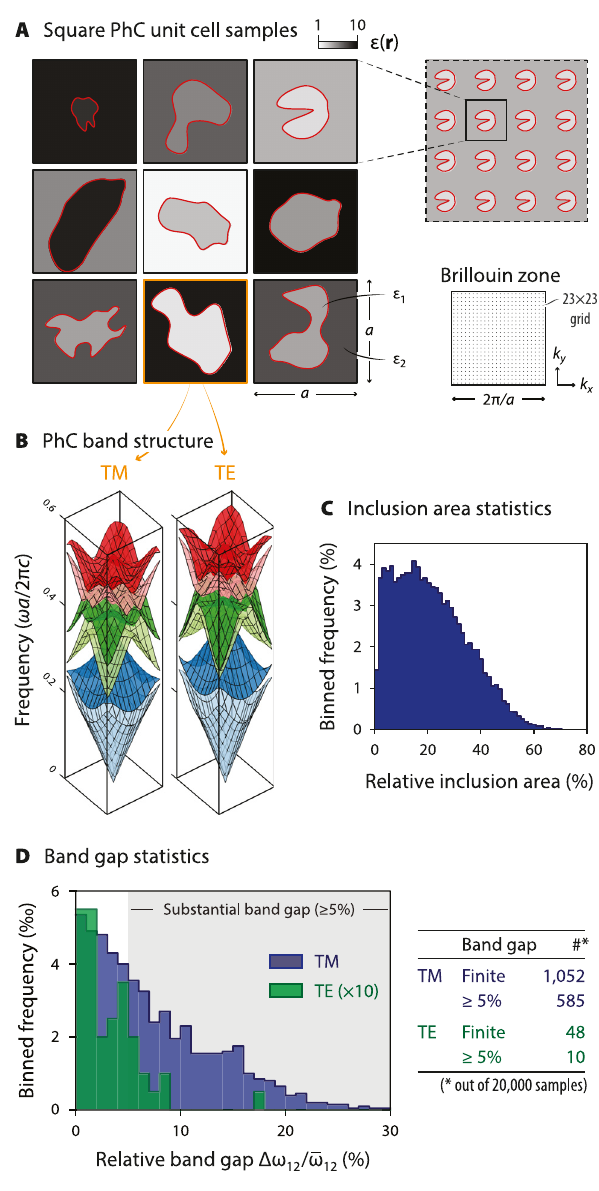
Figure 1: Photonic crystal data set. We generated a data set of 20,000 square 2D PhC unit cells, each consisting of a smooth, centered inclusion of permittivity ε 1 in a background permittivity ε 2 with ε i ∈ [ 1 , 10 ] . (A) Several representative unitcells and theBZ grid- sampling used in the calculation of band structures. (B) The TM and TE band structures of the PhC highlighted in orange in (A). (C) The generated unit cells predominately feature inclusions occupying less than half the unit cell, as illustrated by a histogramming of the relative inclusion areas across the data set. (D) TM band gaps between bands 1 and 2 consequently occur much more frequently than TE gaps, as TE gaps mainly arise in “ fi lamentory ” networks, corresponding to large relative inclusion accurate: the mean fractional deviation per band between calculations at resolutions of 64 × 64 and 32 × 32 is ∼ 0 . 1 ‰ , averaged over all unit cells. Figure 1B shows a set of